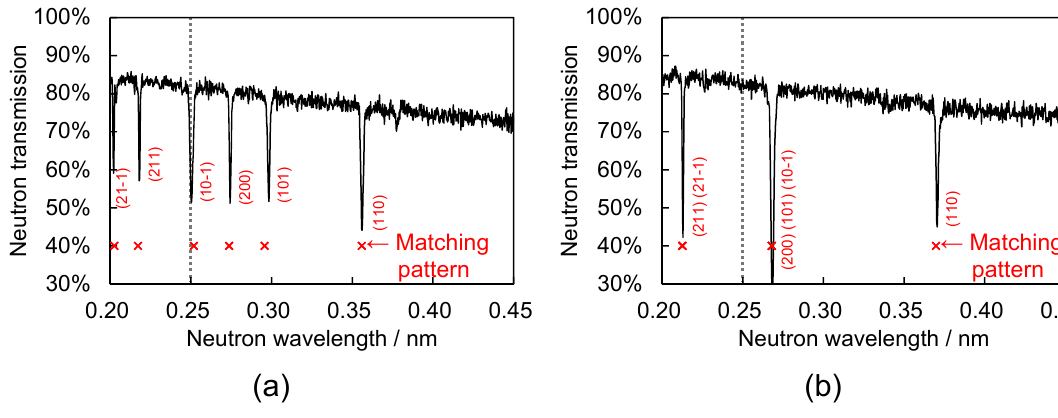
Figure 3. Bragg-dip transmission spectra of ( a ) Grain Orientation 1 and ( b ) Grain Orientation 2 with the pattern matching results (cross × marks) and the indexing results. It is identified by the database matching method that [ UVW ] of Grain Orientation 1 is [100 30 8] and [ UVW ] of Grain Orientation 2 is [100 38 0]. These figures are reproduced with permission of the International Union of Crystallography from Reference [28].